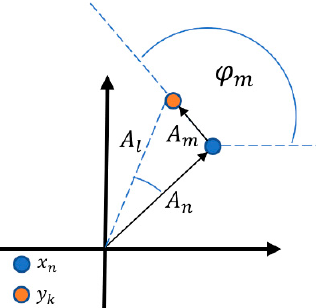
Figure 3. Additional y k and carrier x n constellation points.